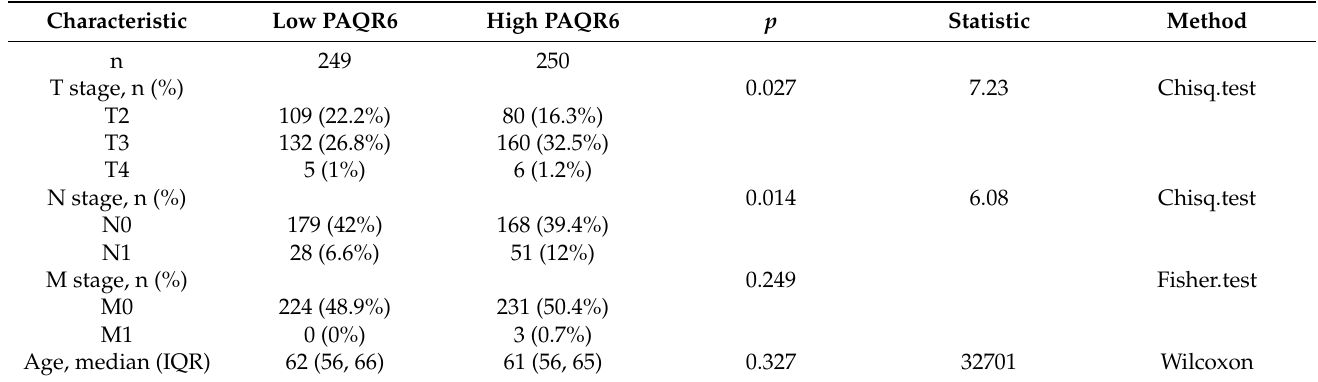
Table 1. Differences of PAQR6 Expression in TNM Categories of Prostate Cancers.